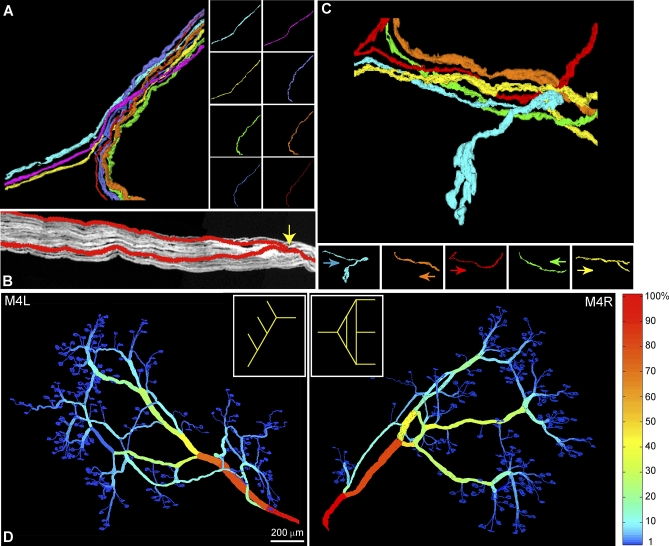
Nerve Fasciculation Pattern and Its Relationship to Axonal Branching(A) A nerve fascicle branched while its constituent axons did not branch.(B) An axon branched within a nerve fascicle. The two resultant branches continued in parallel in the same nerve.(C) Five axonal branches traveled in opposite directions in the same nerve fascicle. Arrows indicate the proximal-distal direction of each branch.(D) Nerve fasciculation patterns were not symmetrical in the left-right pair of muscles. Each nerve fascicle was color-coded according to its innervation weight, which was defined as the percentage of a muscle's NMJs innervated by axonal branches traveling through the fascicle. Insets: a skeleton of these two connectomes (M4L and M4R) were obtained by removing all fascicles with weights less than 10%. The topologies of the two skeletons were different. For example, there were no loops in M4L but two loops in M4R.